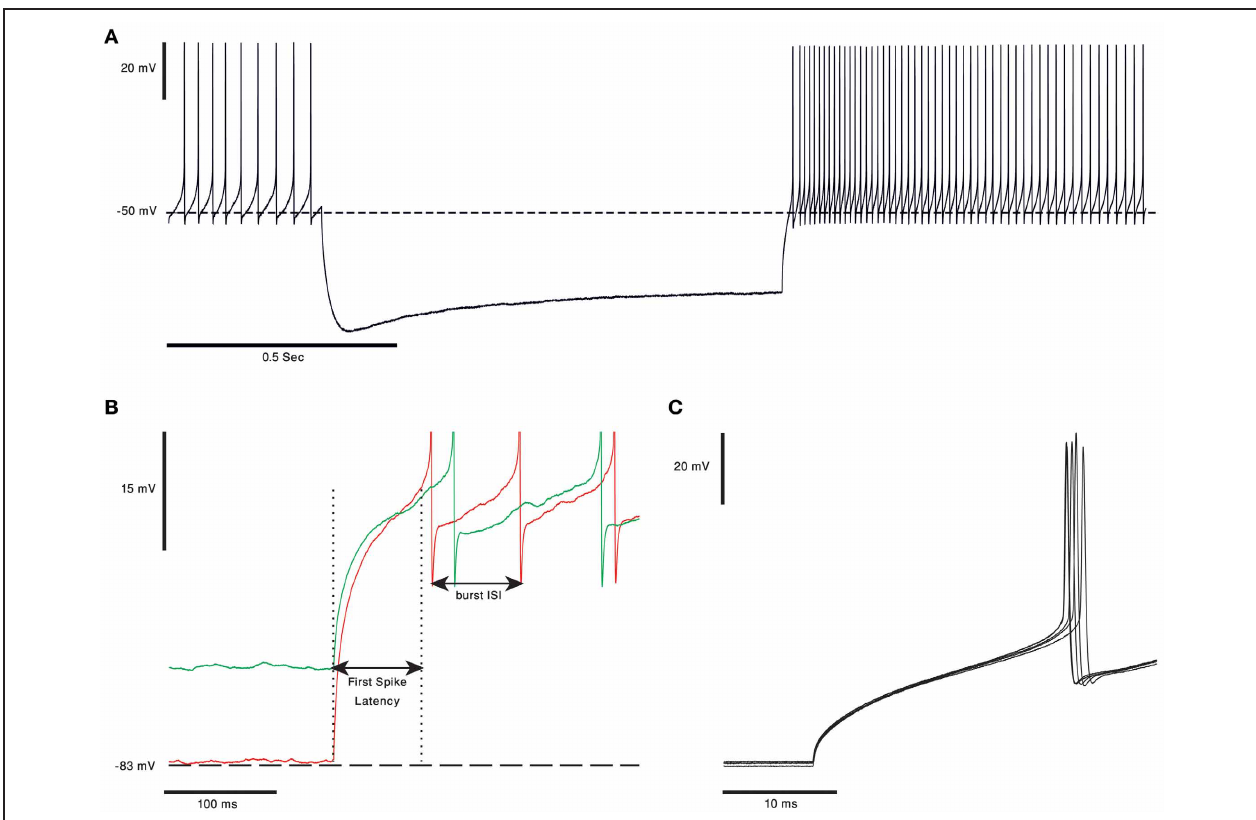
different hyperpolarization levels. The first spike latency was shorter and burst frequency was higher when the membrane voltage was more hyperpolarized (red). Spikes were cut for better visualization. (C) The first spikes in the rebound burst from five repeats of the protocol, from panel (A) , done on the same cell. The latency to the first spike has a clear and noticeable small